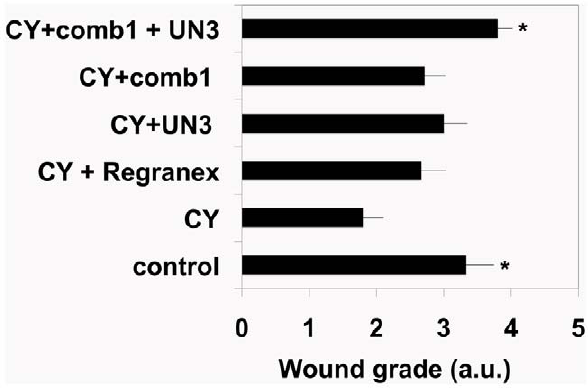
Figure 7. Quantitative evaluation of wound healing responses induced by the peptides in CY-treated mice. Wounds were created, treated, fixed and stained as described in Material and Methods and Figure 5. Grades were assigned to each wound based on criteria described in Table 1. At least 5 wounds were graded for each condition. Data are presented as mean + / 2 standard error; * - indicates p , 0.05 (compared to CY + CMC treated animals).